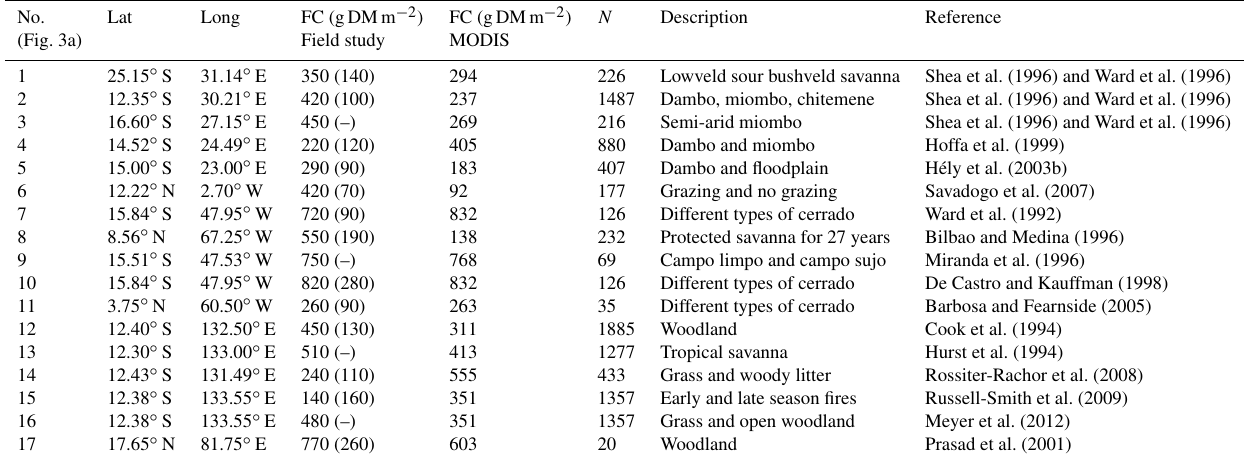
Table 1. Fuel consumption estimates for grasslands, savannas and woody savannas, based on field studies compiled by van Leeuwen et al. (2014) and the corresponding 0.25 ◦ fuel consumption estimates derived here. For the field studies, numbers in parentheses show the standard deviation. N is the number of active fire detections by MODIS (2003–2014) for each 0.25 ◦ grid cell. No. Lat Long FC (gDMm − 2 ) FC (gDMm − 2 ) N